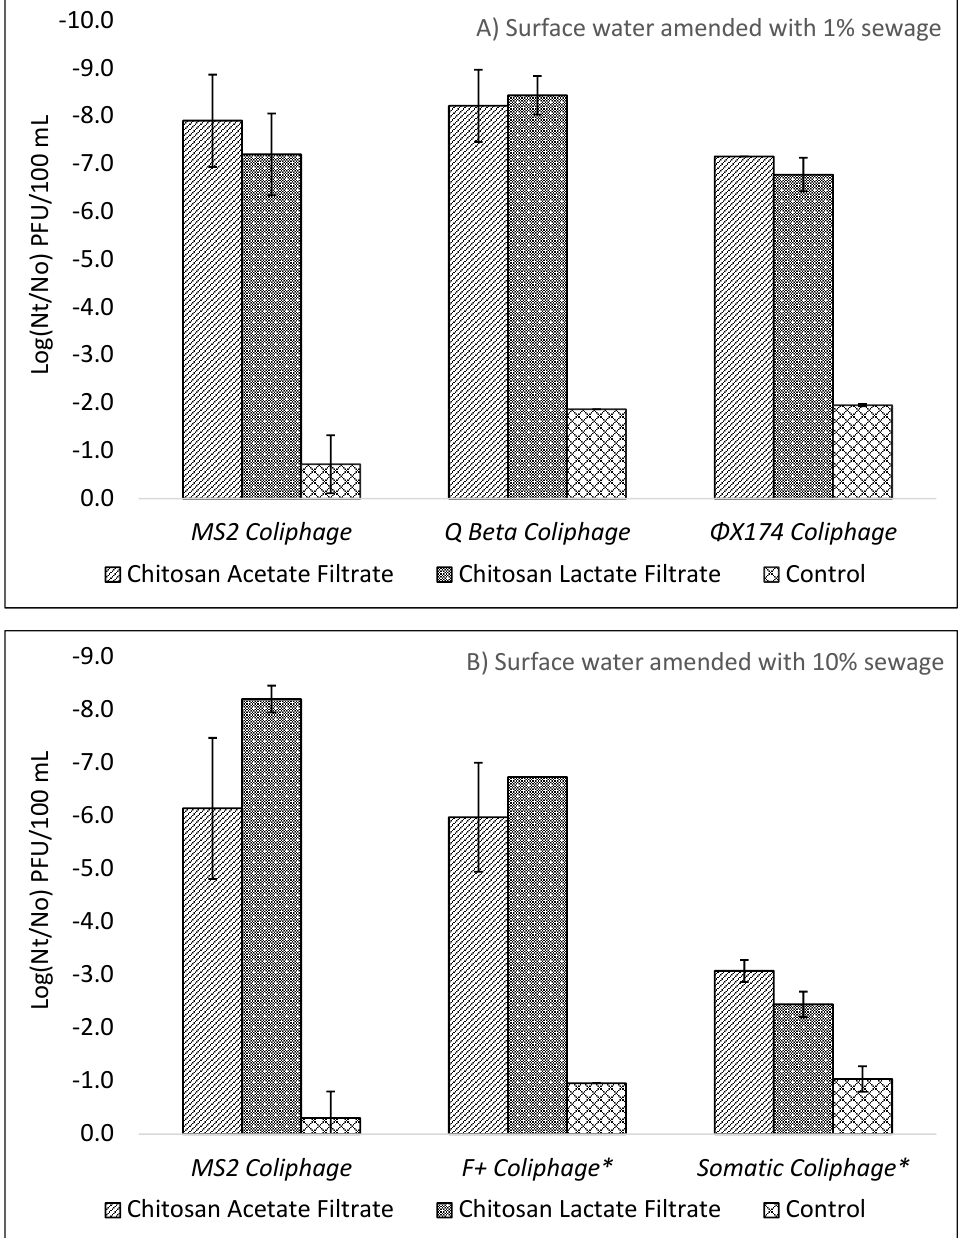
Figure 2. ( A , B ) Average virus log reductions after pretreatment with 30 mg/L chitosan acetate or chitosan lactate followed by ceramic filtration for natural surface water amended with ( A ) 1% pasteurized sewage and ( B ) 10% pasteurized sewage (error bars indicate standard deviation). Virus with * in ( B ) indicate wild type total coliphage viruses derived from unpasteurized